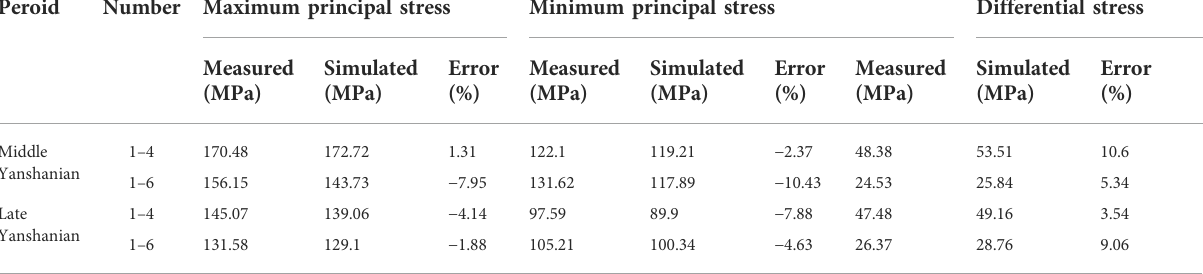
TABLE 3 Comparison of tested and simulated results of paleo-tectonic stress fi eld. Peroid